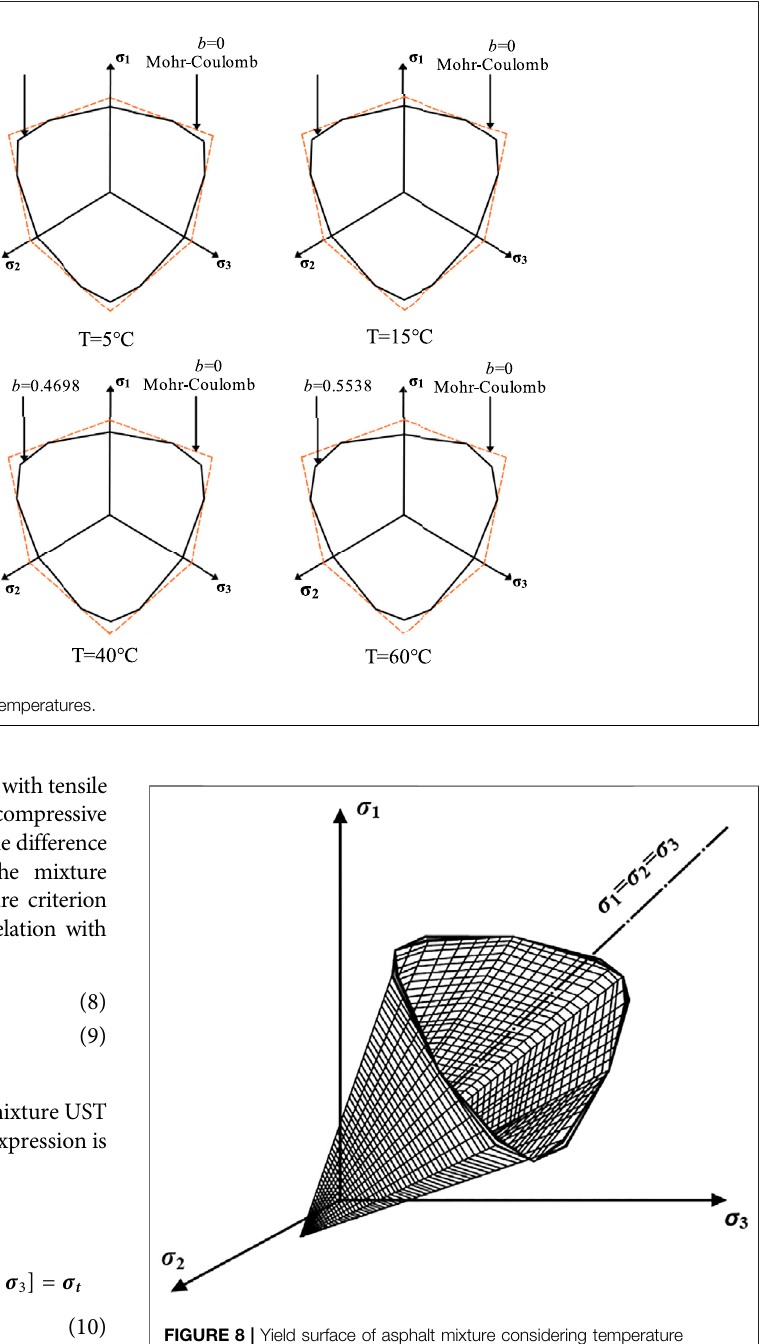
FIGURE 8 | Yield surface of asphalt mixture considering temperature and intermediate principal